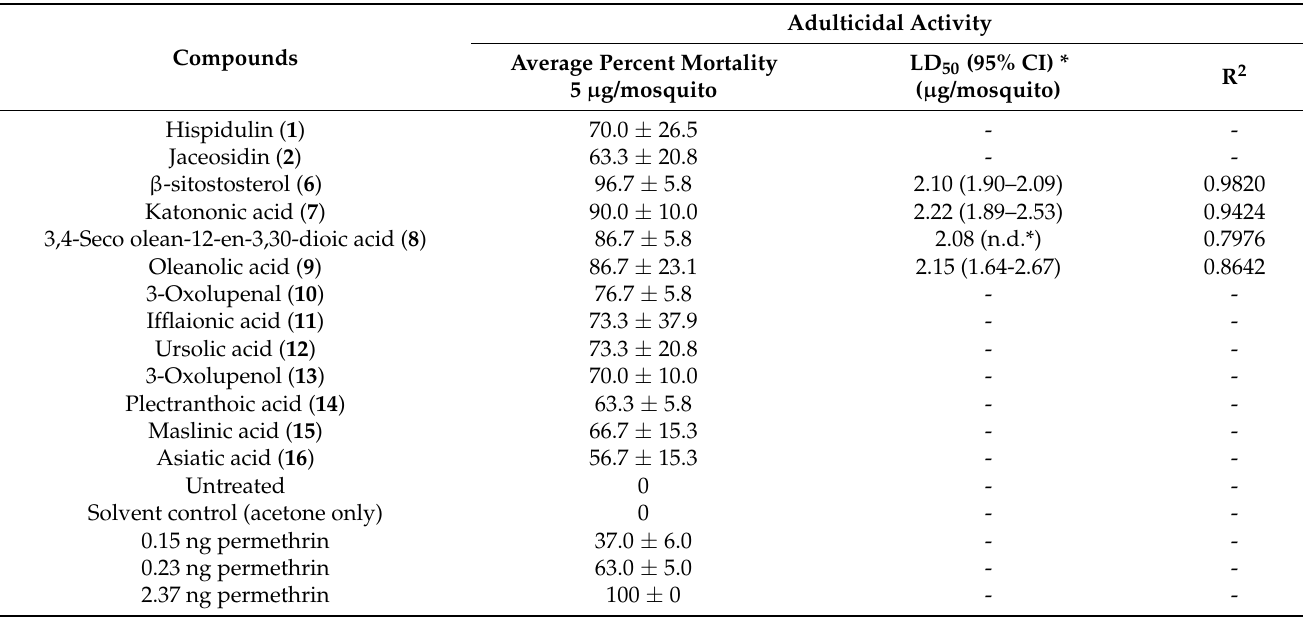
Table 1. Percent mortality of N. oppositifolia isolated compounds ( 1 , 2 , 6 – 16 ) at 24 h using the ORL1952 strain of Ae. aegypti ( n =